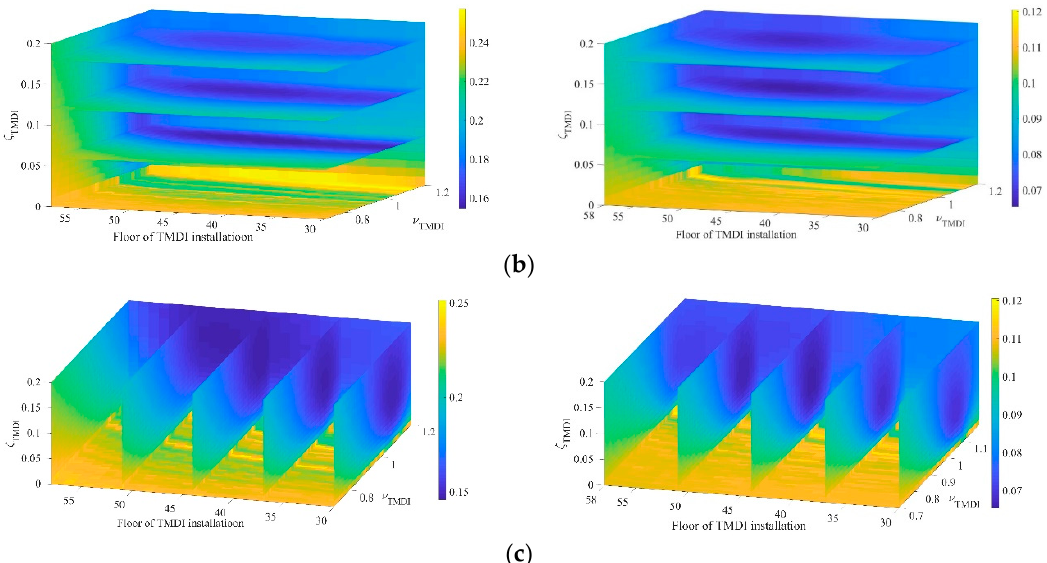
Figure 7. Peak displacement ( left ) and acceleration ( right ) at top floor of TMDI-equipped structure at wind direction of 90 ◦ in the υ − ζ − t space. ( a ) Distributions of peak displacement ( left ) and acceleration ( right ) at constant frequency ratios ( υ = 0.7, 0.8, 0.9, 1.0, 1.1, 1.2). ( b ) Distributions of peak displacement ( left ) and acceleration ( right ) at constant damping ratios ( ζ = 6%, 12%, 18%). ( c ) Distributions of peak displacement ( left ) and acceleration ( right ) at constant floor of TMDI installation ( t = 30, 37, 44, 51, 58). From the sliced contour shown in Figure 7, the cool-color area represents the most e ffi cient combination of parameters, leading to the minimum value of the two specific response